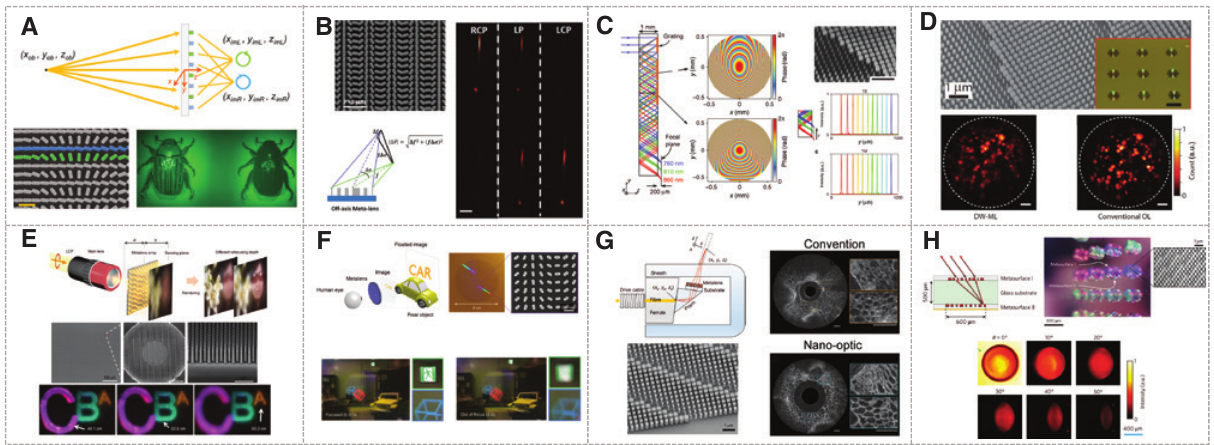
Figure 8: Recent applications of metalenses in devices. Each figure is arranged in order of mechanism, SEM image, and experimental result. (A) Multispectral chiral imaging with a metalens [144]. (B) Ultracompact visible chiral spectrometer with metalenses [145]. (C) Compact folded metasurface spectrometer [146]. (D) Two-photon microscopy with a double-wavelength metasurface objective lens [147]. (E) Achromatic metalens array for full-color light-field imaging [148]. (F) Metasurface eyepiece for AR [99]. (G) Nano-optic endoscope for high-resolution optical coherence tomography in vivo [149]. (H) Planar metasurface retroreflector